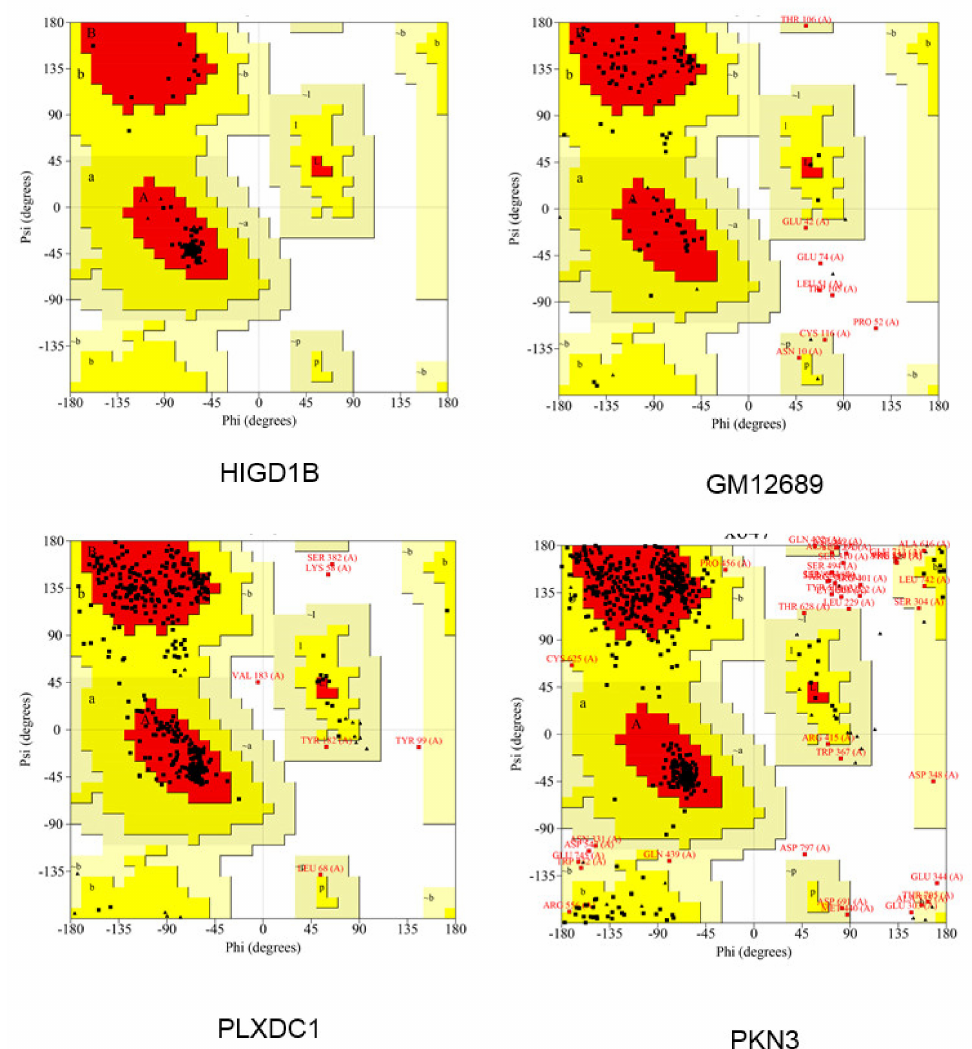
Figure 12. Ramachandran plot of the modeled 3D protein structures of hub proteins. The different colored areas demonstrate ‘generously allowed’ (yellow), ‘disallowed’ (beige), and ‘most favored (red)’